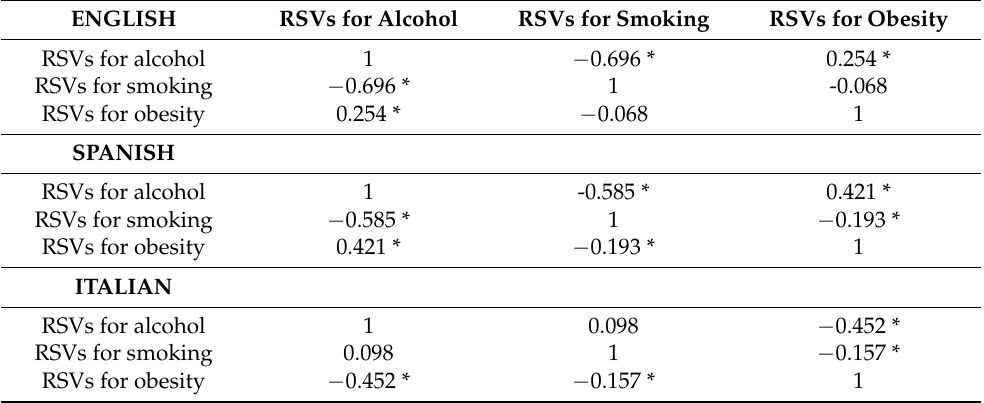
Table 4. Correlation coefficients of searches performed using country-specific languages (English, Spanish, and